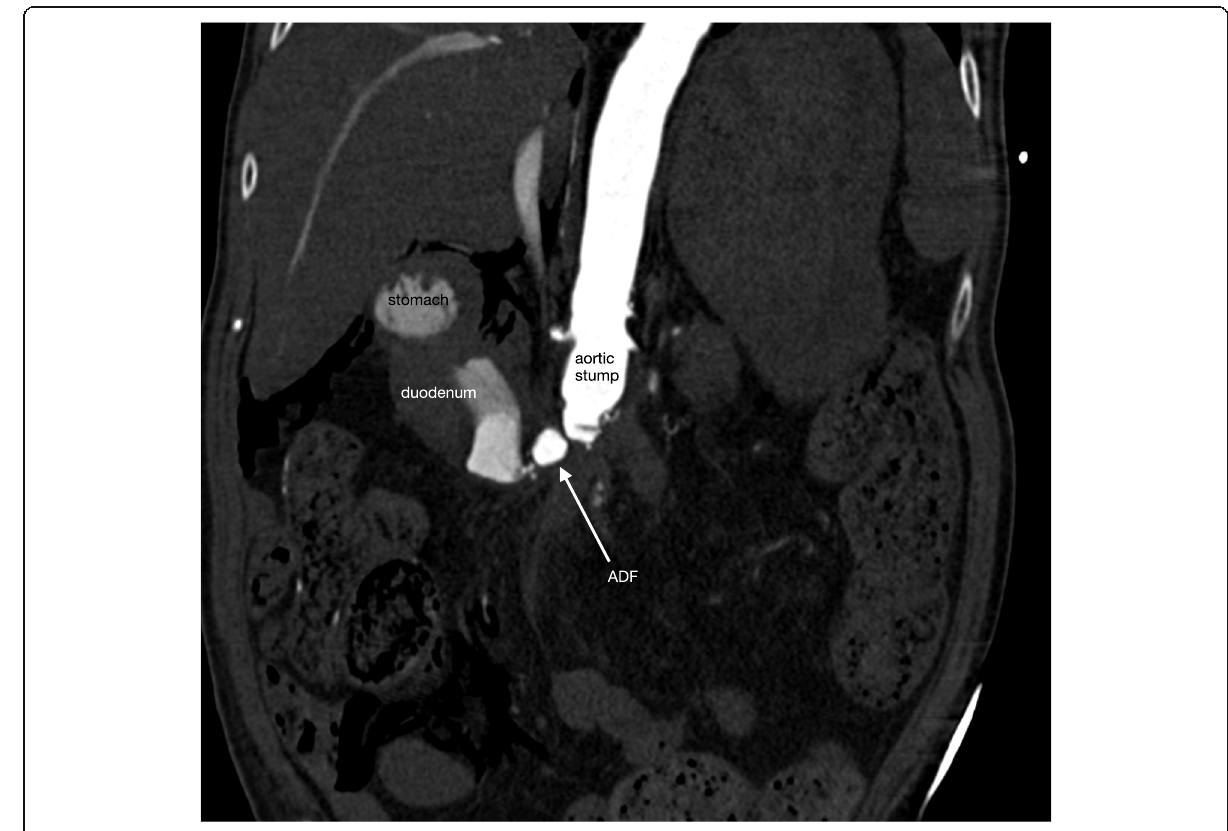
Fig. 1 CTA abdomen showing massive extravasation of blood due to a secondary ADFCTA demonstrating massive extravasation of blood through the aortic stump into the duodenum, due to a secondary ADF (marked with an